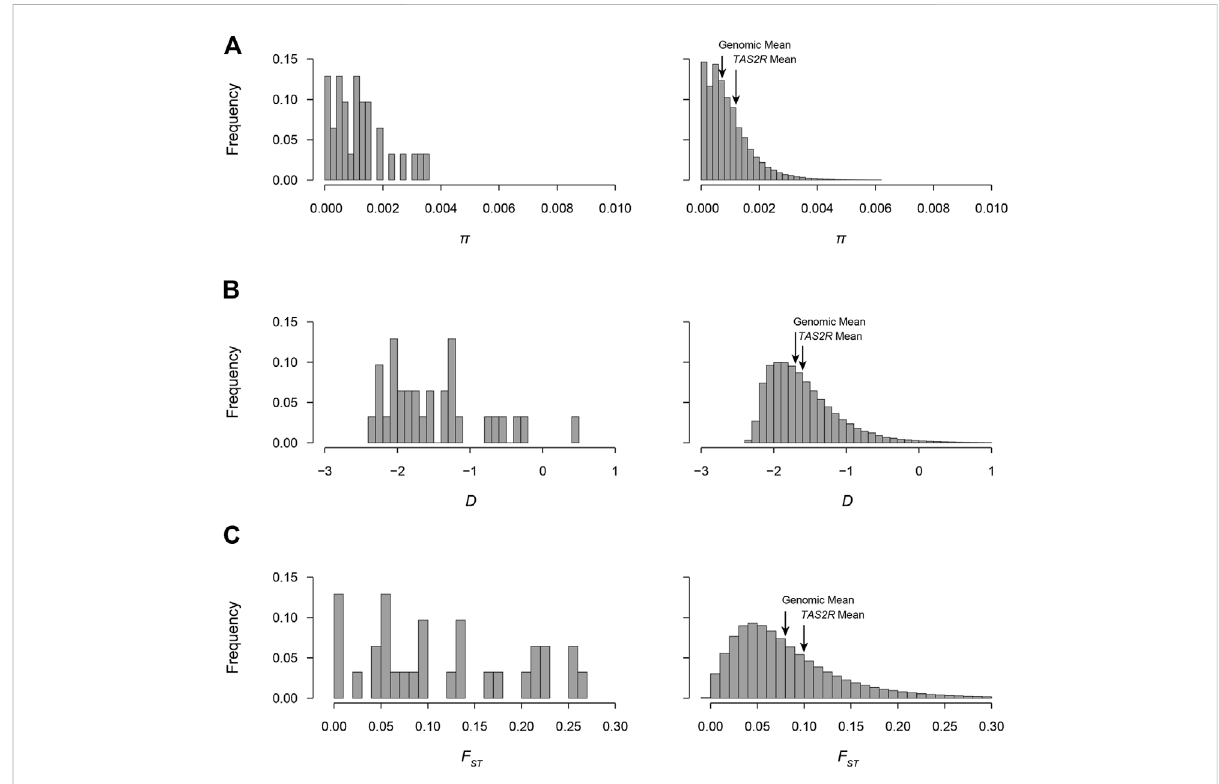
FIGURE 2 Distributions of π , Tajima ’ s D , and F ST in the 1000GP. Values observed in TAS2R s and genome-wide sliding windows are shown in the left and right of each panel, respectively. (A) π distributions. Mean values in TAS2R s and genome-wide were 0.0012 and 0.0009, respectively. (B) D distributions. Mean values in TAS2R s and genome-wide were − 1.61 and − 1.59 and. (C) F ST distributions. Mean values in TAS2R s and genome-wide were 0.13 and 0.08.